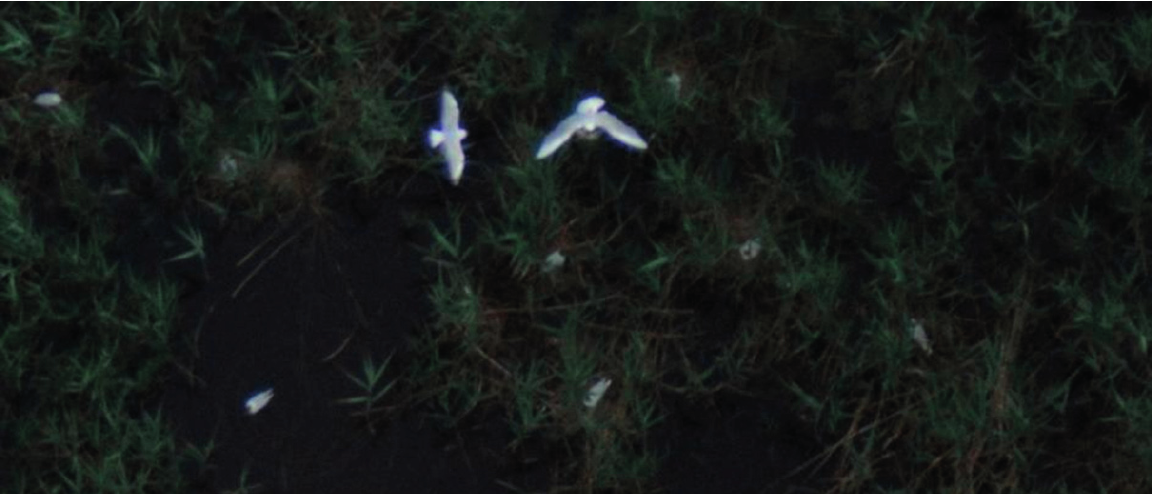
Figure 6. The full resolution shows that stationary and flying birds from the black-headed gull colony are easily identifiable, even in low visibility